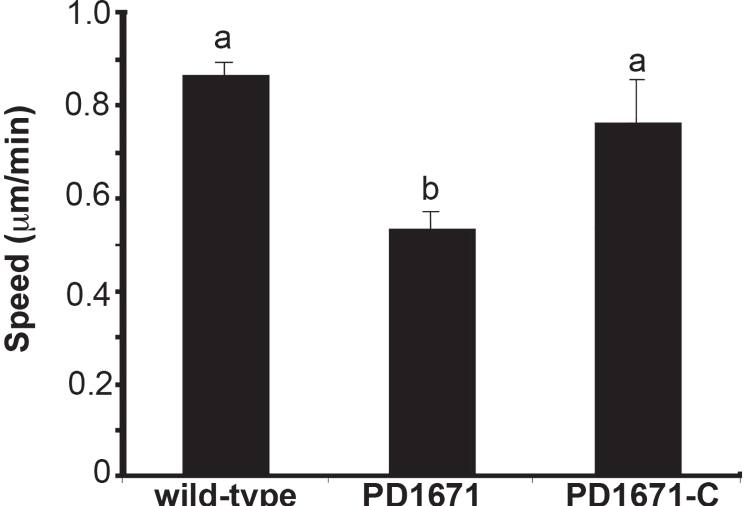
Fig 3. Movement of the X . fastidiosa PD1671 mutant in microfluidic chambers. Twitching movement speed of wild-type X . fastidiosa Temecula 1, PD1671 mutant, and complemented PD1671 mutant (PD1671-C) cells in microfluidic flow chambers. Values shown are means and standard errors from three independent experiments. Letters above bars indicate significant differences by Kruskal-Wallis test and means were separated by the Kruskal-Wallis all pairwise comparison test ( P = 0.02)